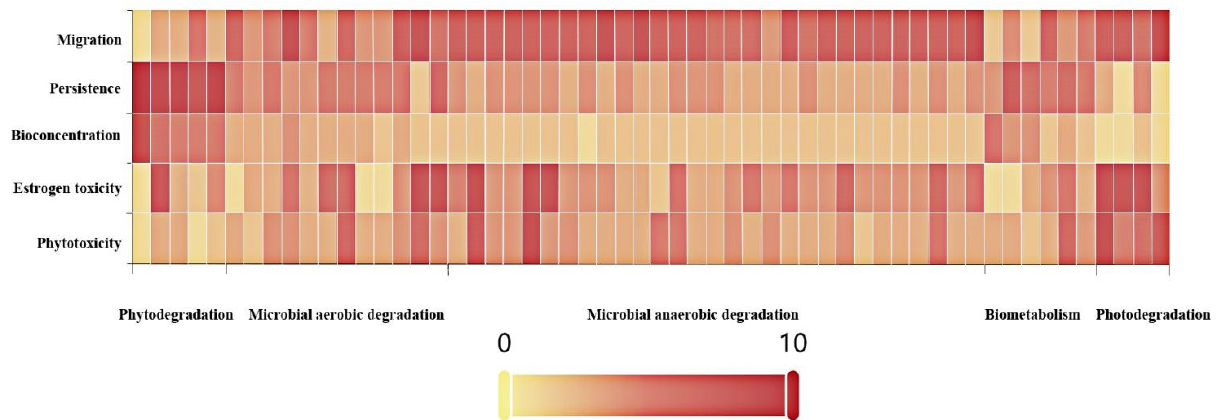
Figure 4. Environmental risk characteristics of the PCB transformation products under different degradation pathways.